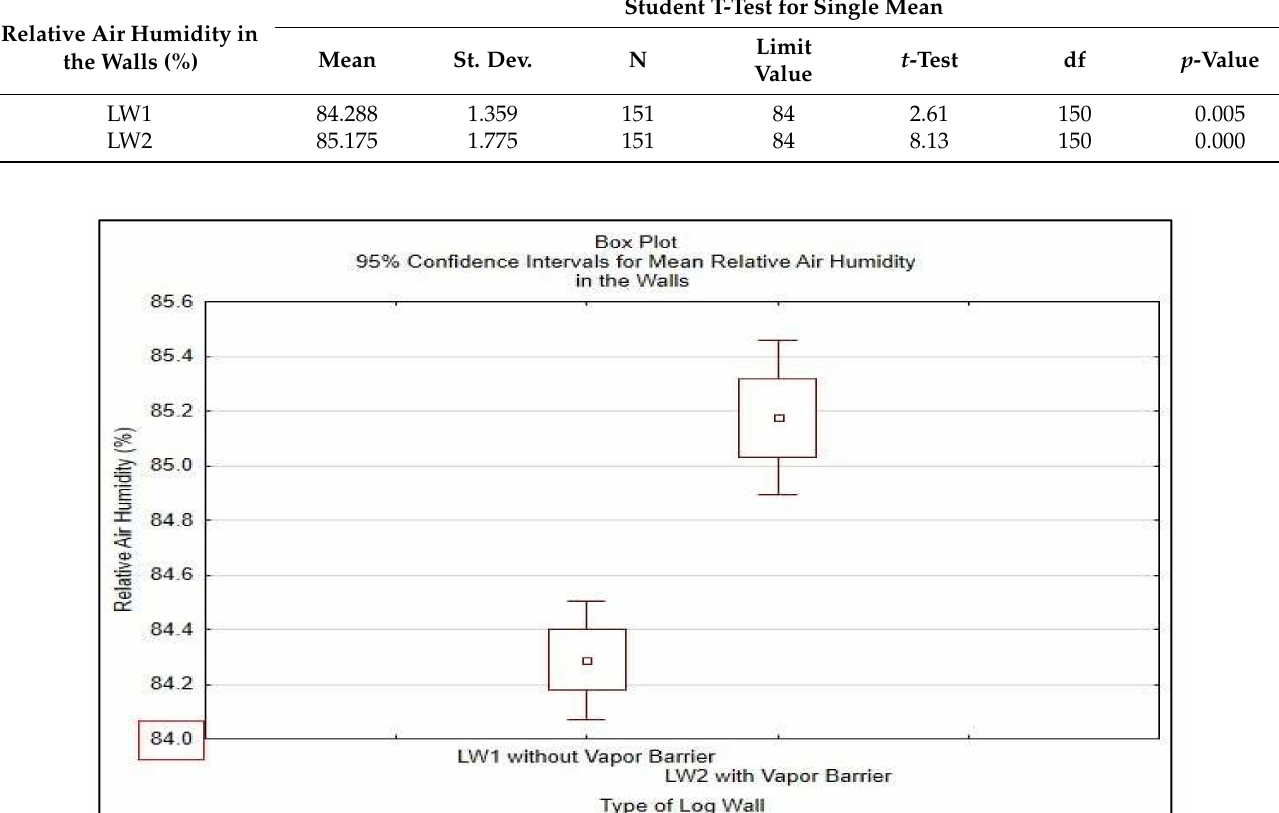
Relative Air Humidity in the Walls